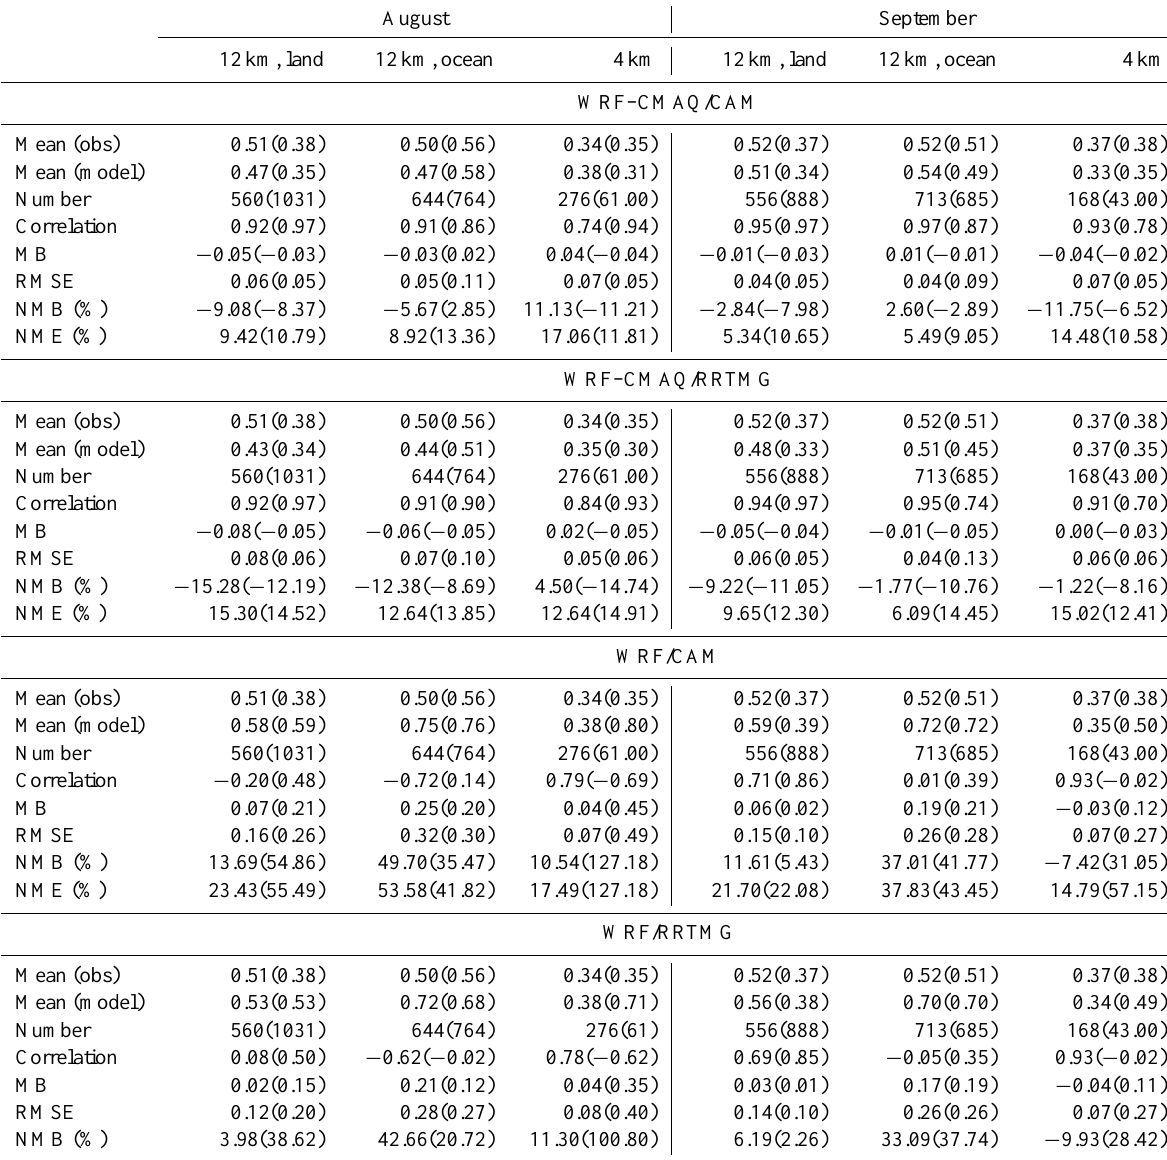
Table 12. Same as Table 9, but for monthly cloud fractions in August and September of